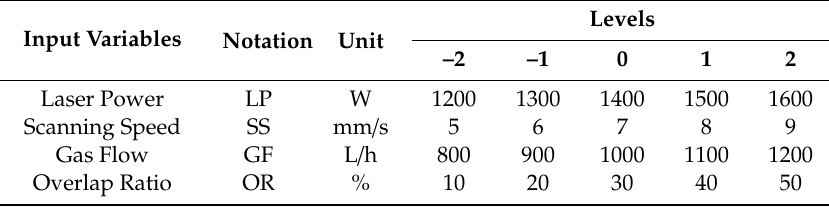
Table 2. Laser cladding processing parameters in central composite